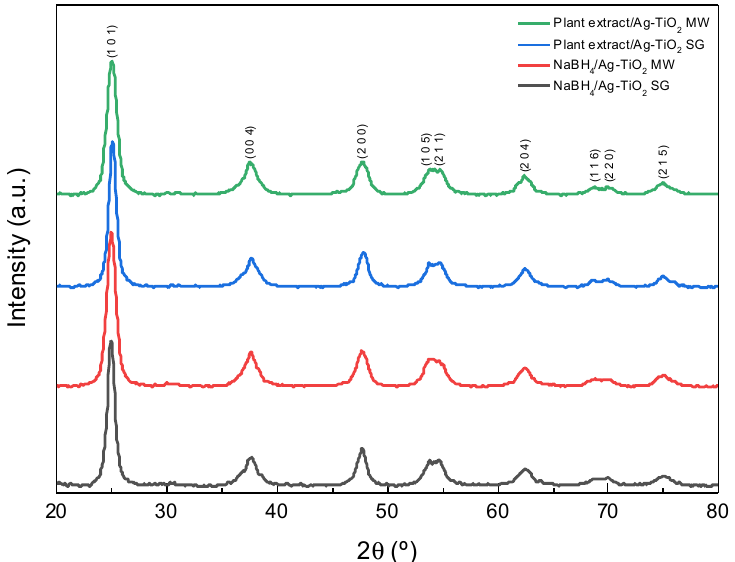
Figure 6. Ag-TiO 2 X-ray diffraction patterns ( - ) NaBH 4 /Ag-TiO 2 SG, ( - ) NaBH 4 /Ag-TiO 2 MW, ( - ) plant extract/Ag-TiO 2 SG, ( - ) plant extract/Ag-TiO 2 MW. The Scherrer equation determined the crystallite size, 𝐷 =